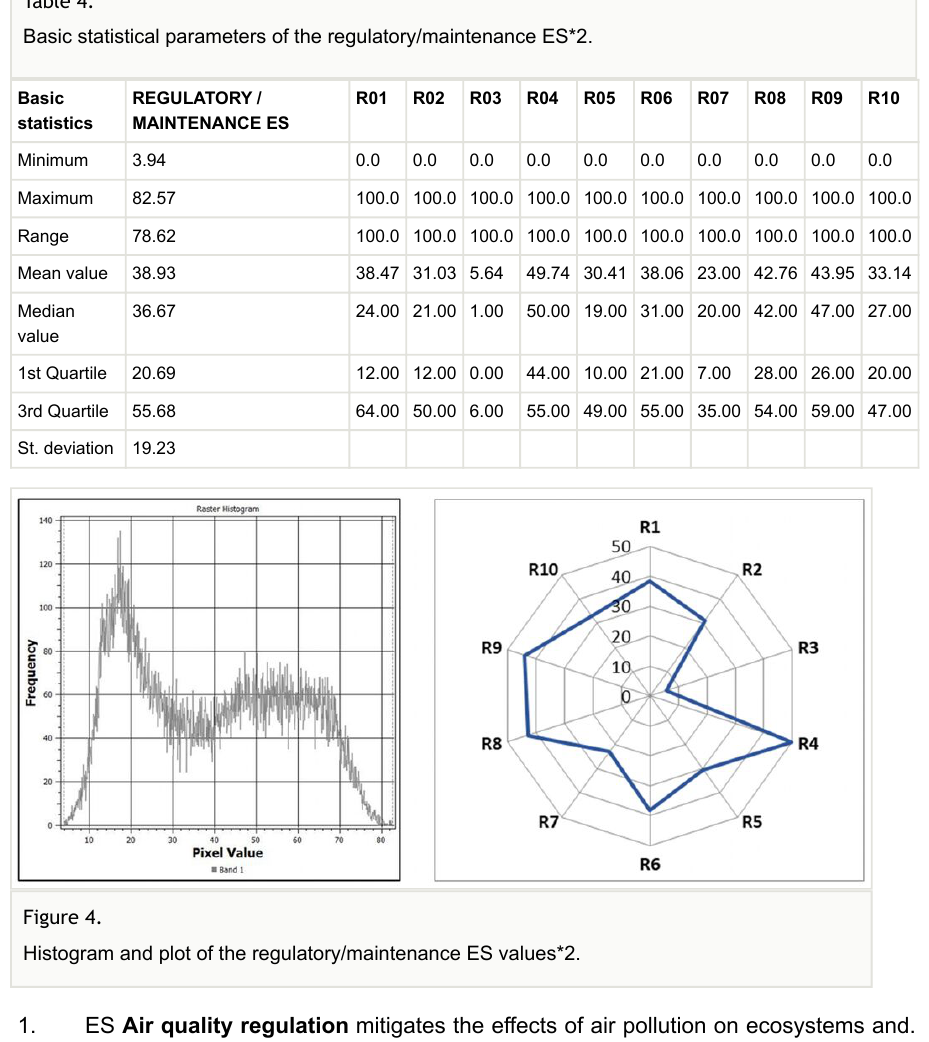
Figure 4. Histogram and plot of the regulatory/maintenance ES